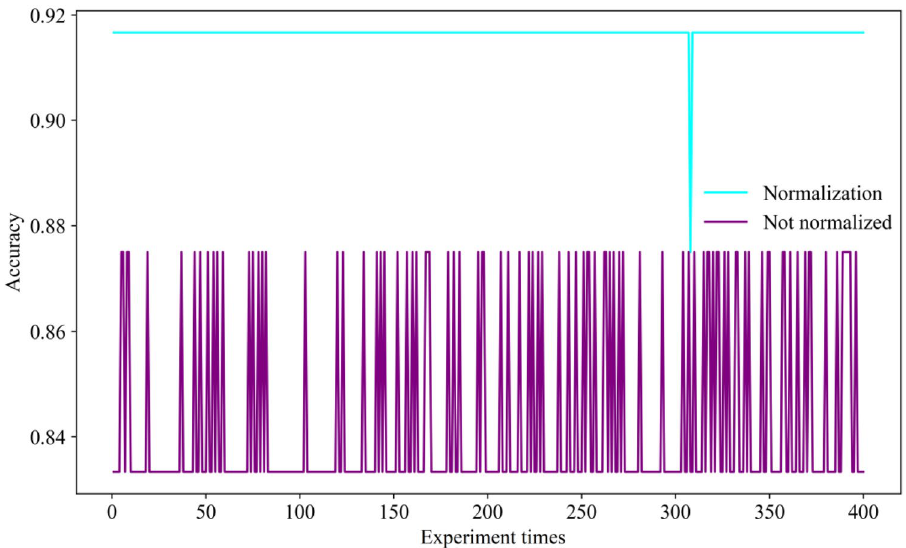
Figure 6. The training accuracy vs experiment times by the data set.